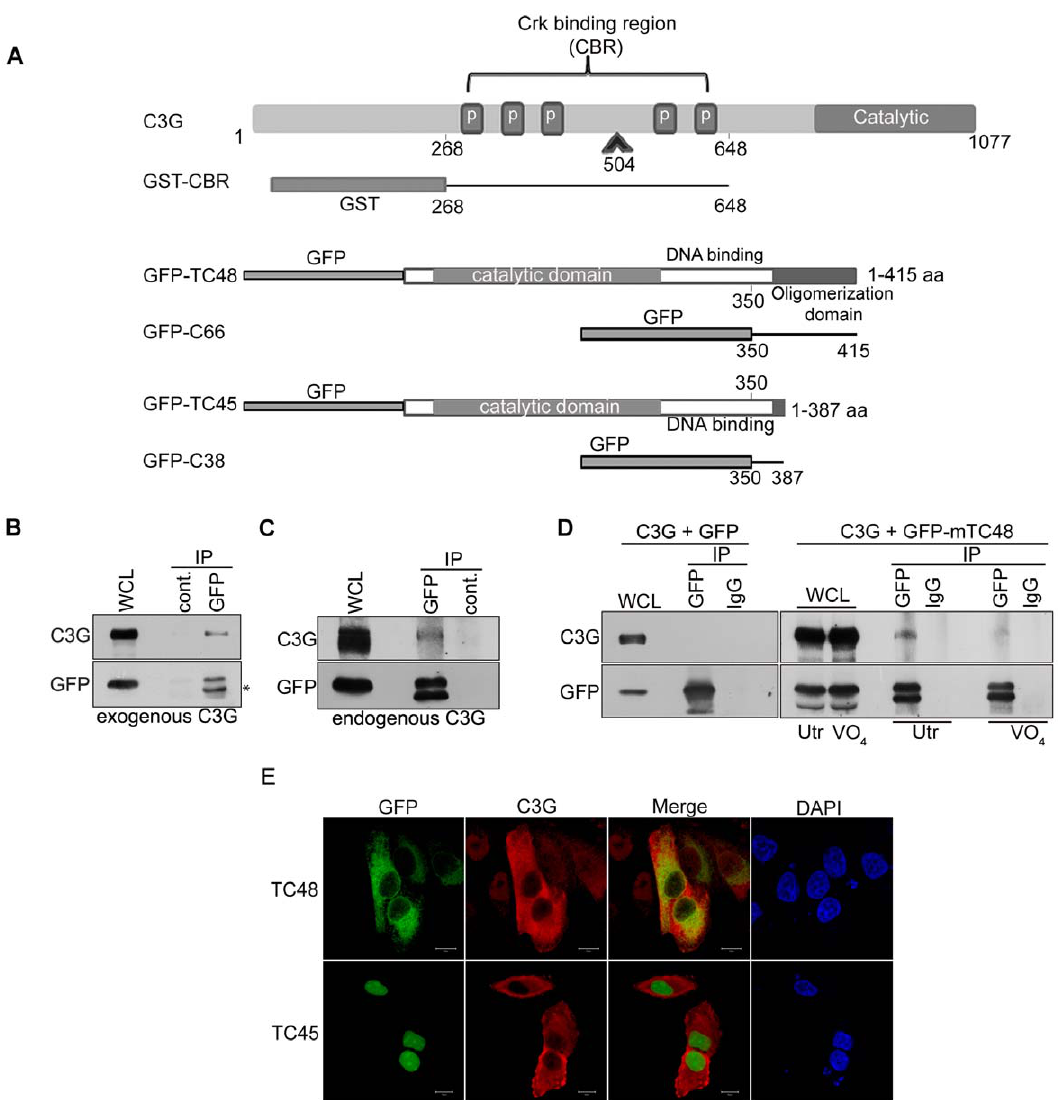
Figure 1. C3G interacts with TC-PTP: (A) Schematic showing domain organization of C3G and the two splice variants of TC-PTP, TC48 and TC45 as GFP fusion proteins. Fusion proteins of GFP with C-terminal sequence of TC48 and TC45 are also shown. Recombinant GST fusion protein of the Crk binding region of C3G is also shown (GST-CBR). (B) C3G co-precipitates with mTC48 from cell lysates. HEK-293 cells transfected with C3G and GFP- mTC48 were subjected to immunoprecipitation using control mouse IgG or GFP antibodies. The immunoprecipitates were analyzed for western blotting with C3G and GFP antibodies. Whole cell lysates (WCL) used for immunoprecipitation are also included to show expression of the protein. * indicates partially degraded mTC48 in lysates during immunoprecipitation. (C) Interaction of mTC48 with cellular C3G. Experiment was carried out as in (B) using lysates of cells transfected with mTC48 alone. (D) Interaction of mTC48 with C3G is abrogated by vanadate. GFP-mTC48 was immunoprecipitated from lysates of HEK293 cells expressing C3G and GFP-mTC48, left untreated (Utr) or treated with 50 m M vanadate (VO 4 ) for 4 hrs. Cells were subjected to 10 min treatment with PV to stimulate C3G phosphorylation prior to lysis. Along with lysates (WCL), the immunoprecipitates were subjected to Western blotting with the indicated antibodies. Immunoprecipitation was also carried out from cells expressing GFP and C3G as a control. (E) Sub-cellular localization of C3G and TC-PTP. IMR-32 cells transfected with C3G and either GFP-TC48 or GFP-TC45 were stained for C3G and analyzed by confocal microscopy. A section through the centre of the nucleus is shown. Bar, 10 m